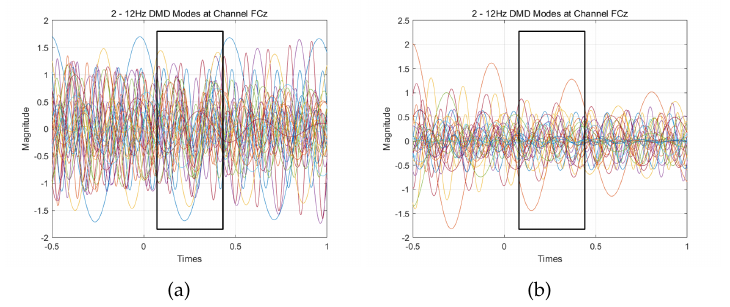
Figure 6. The time evolution of 2 − 12 Hz DMD modes at FCz channel. ( a ) ErrP. ( b ) No ErrP. (Take the recording in session 2 of subject 3 in the monitoring error-related potentials dataset as an